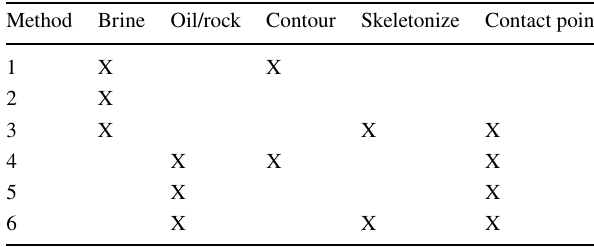
Figure 1 summarizes the classification procedure of pix- els during the mapping process. Each image represents a 3x3 matrix, in which the cell with an “X” mark represents the pixel to be classified, and the colors black, light gray, and white represent the oil, the brine, and the rock, respectively.